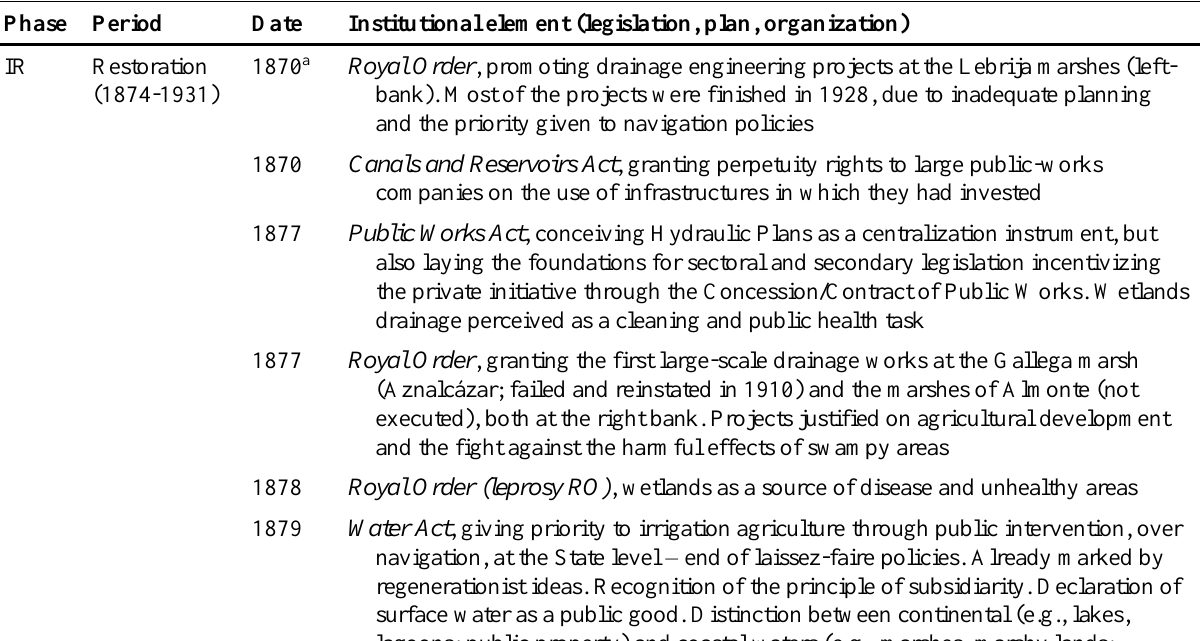
Table A2.1. Historical profile – includes only the period comprised between 1870 and the 1990s (IR = increasing-returns, SR = self-reinforcement)